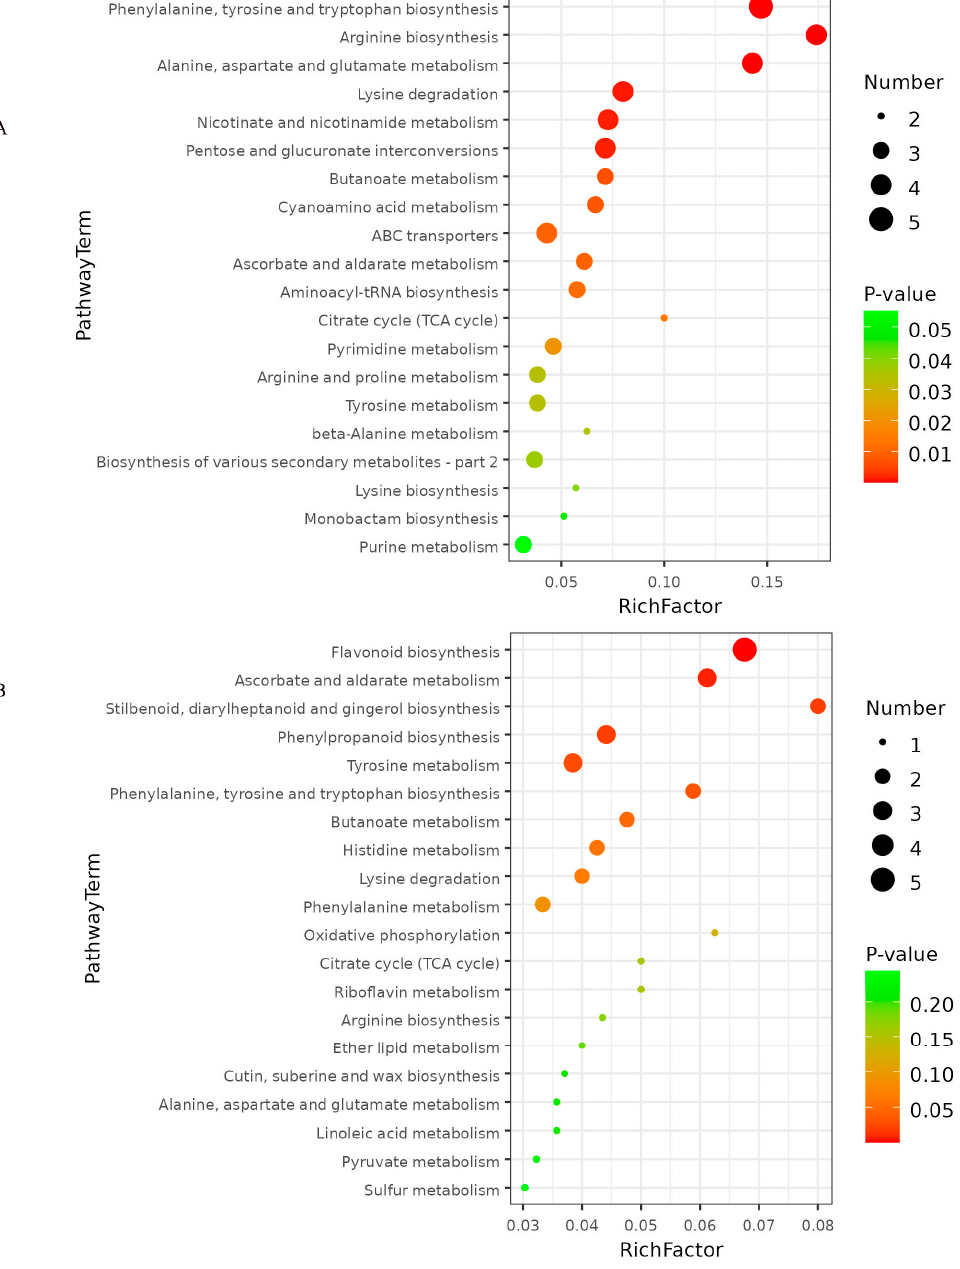
Figure 9. Pathway analysis of differentially abundant metabolites from GC-MS ( A ) and LC-MS ( B ) based on pathway-matched metabolites.